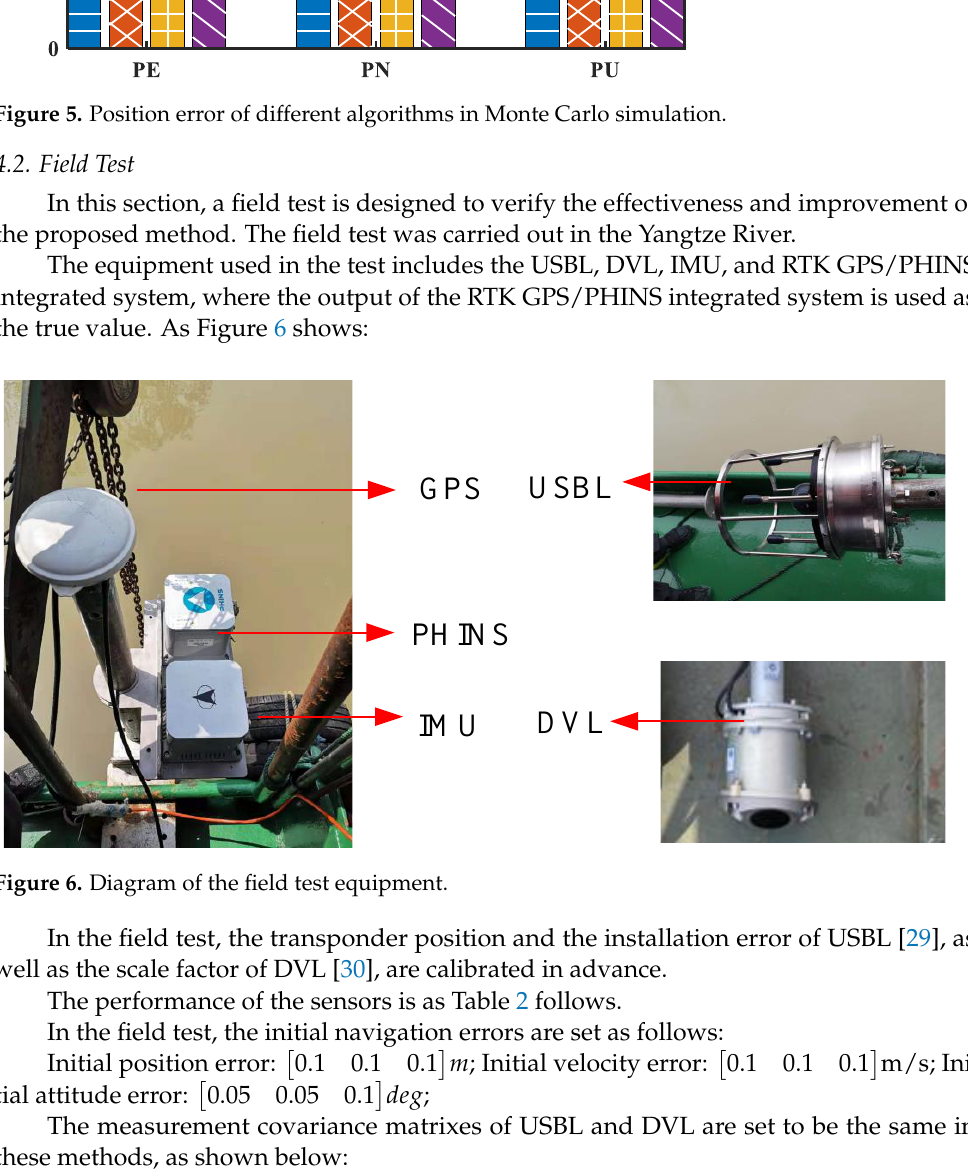
Table 2. Parameters of the sensors.